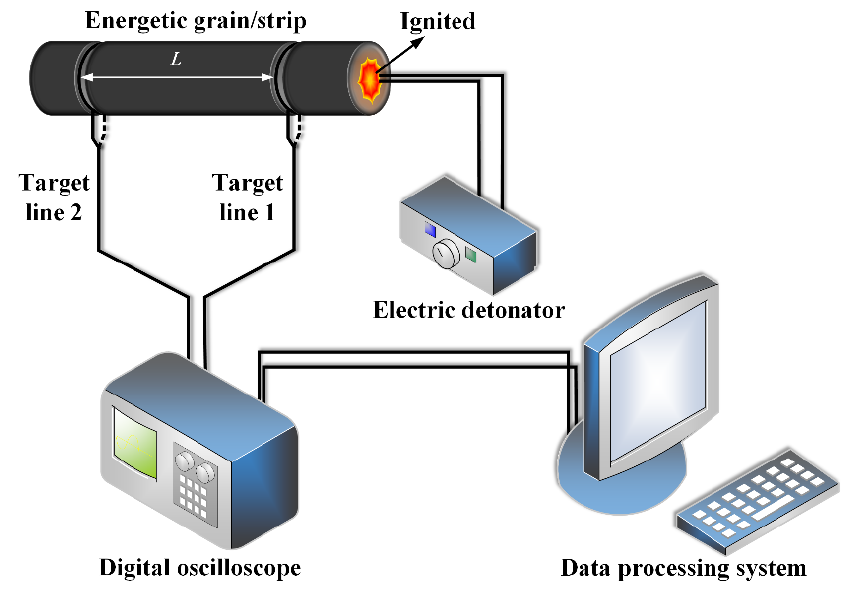
and the standard deviation is 0.32.